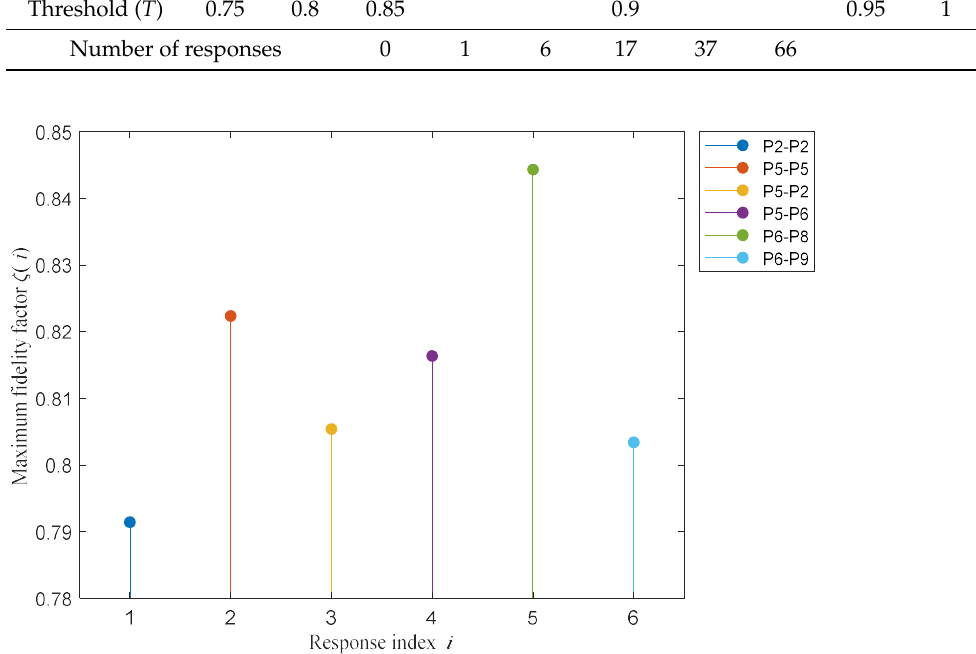
Table 4. Number of responses with maximum fidelity factor less than or equal to the threshold T . Figure 16. Number of responses that have maximum fidelity factor less than or equal to the given threshold T .